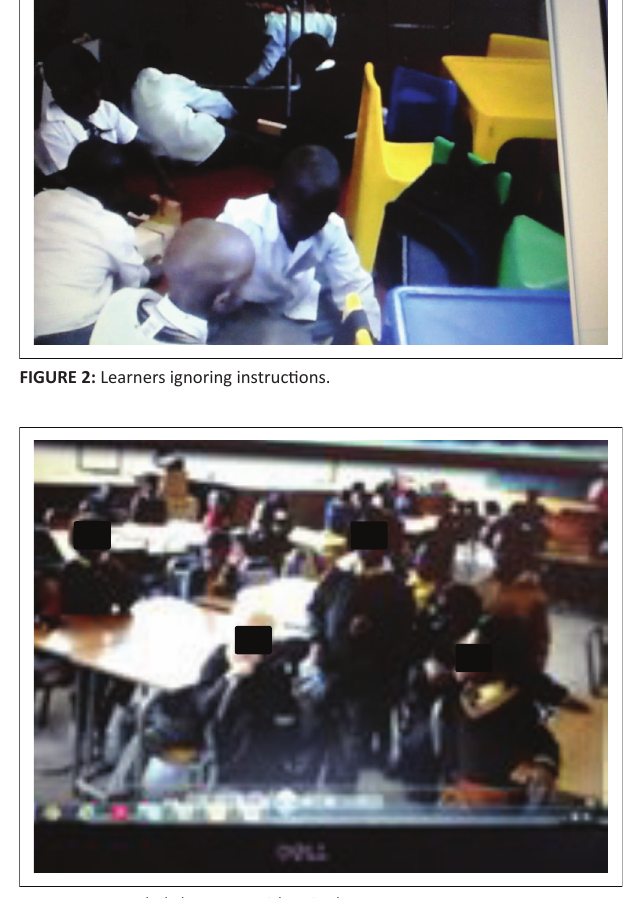
FIGURE 3: Crowded classroom with noisy learners.